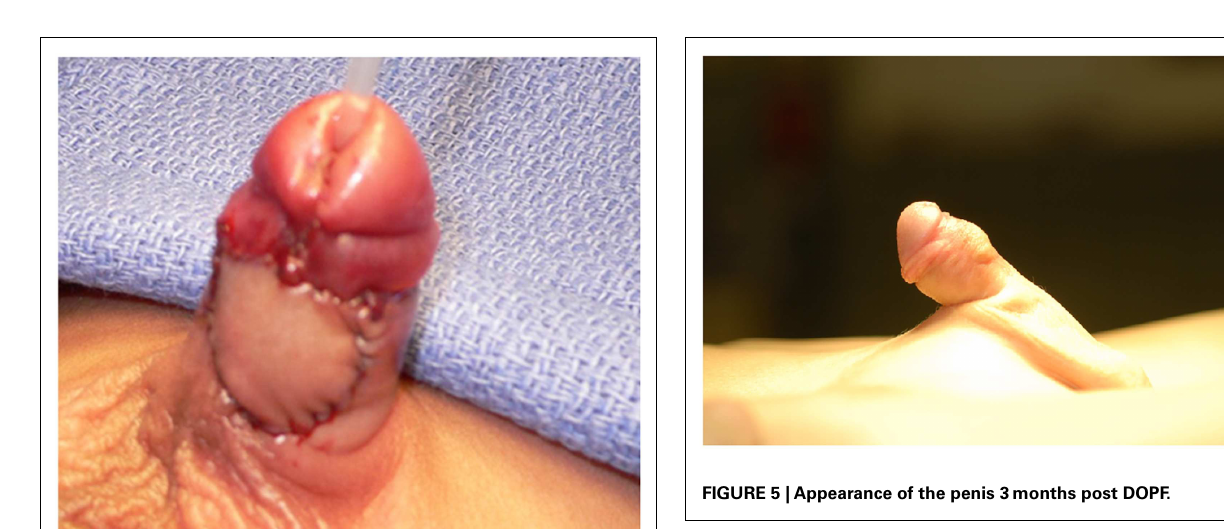
FIGURE 3 |TheTPF has been transposed ventrally and is normally rotated 90°. This does not compromise the blood supply. It is then used for the onlay urethroplasty (outer layer), ventral coverage, or both. The patient in the illustration had penoscrotal hypospadias.The chordee